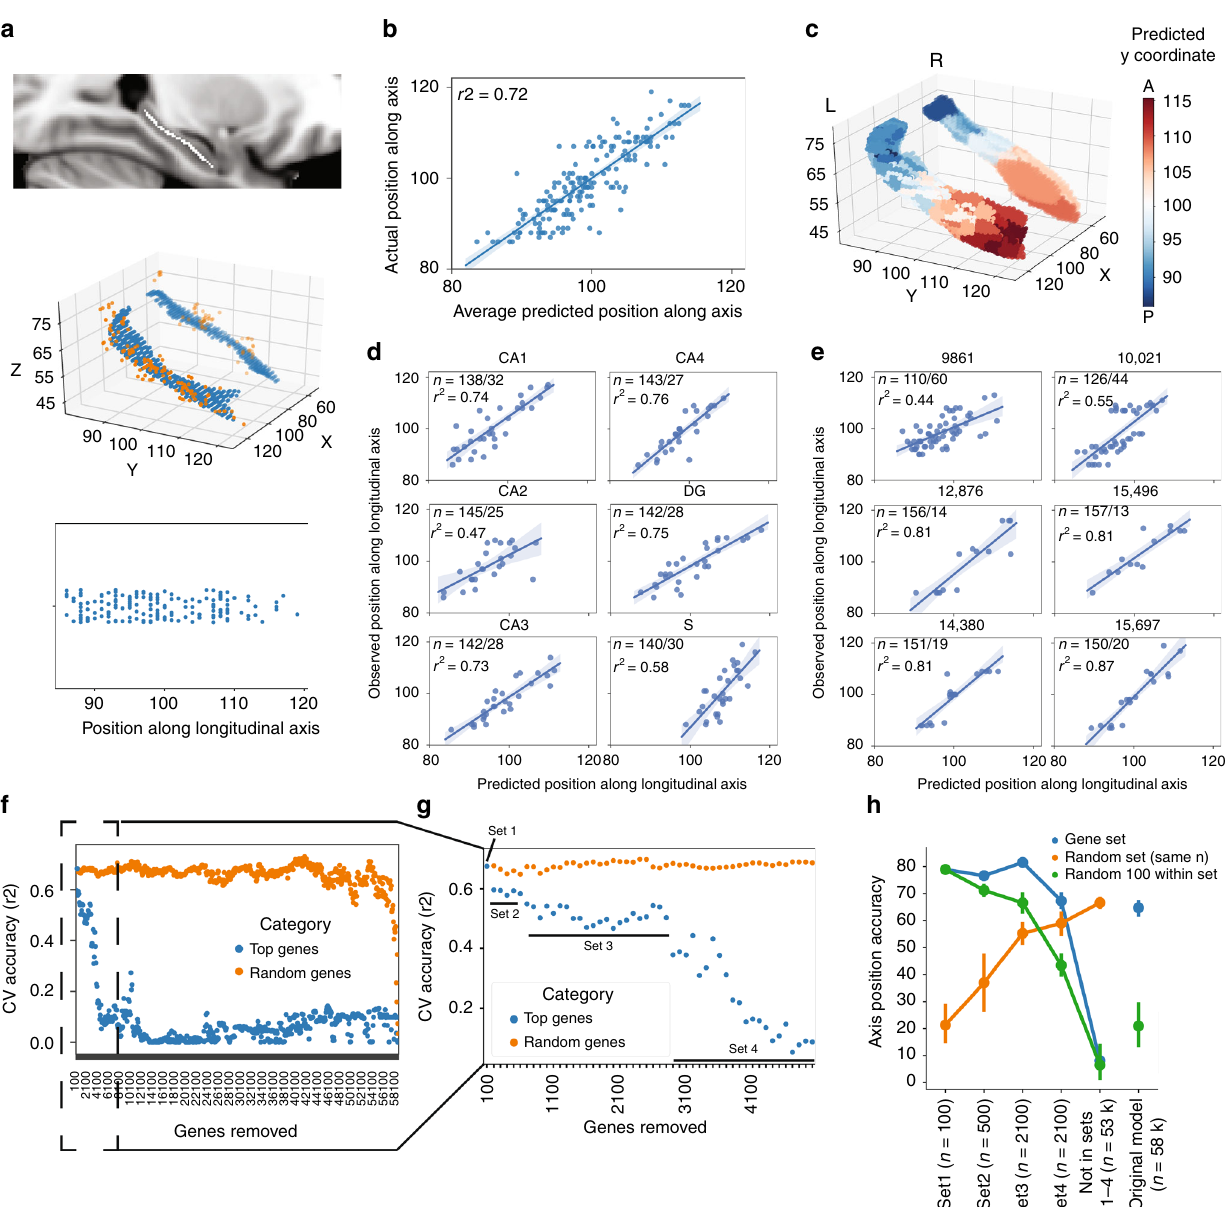
Fig. 1 Gene expression predicts the location of tissue samples along the long axis of the hippocampus. a (top) A curved skeleton of voxels was fi tted along the center of mass of the hippocampal volume. (middle) Tissue samples (orange) were matched to the closest skeleton voxels (blue). (bottom) A sample's position along the longitudinal axis was represented as the y-axis coordinate of the sample's matched skeleton-voxel. b Average predicted sample position (using gene expression) across ten separate 10-fold cross-validated LASSO-PCR models, compared to the actual position. c Render of the hippocampal surface where each vertex shows the predicted location of the closest (surface projected) sample to that vertex. The smooth appearance of the right hippocampus is related to the fact that less samples were available for this structure. d Predicted vs. observed sample locations for leave-one- sub fi eld-out models. For example, subpanel CA1 shows the predicted vs. observed position of samples extracted from CA1 (test set) when the model was trained without CA1 samples (training set). In each plot, N represents the number of samples in the training and test sets. e Predicted vs. observed sample locations for leave-one-donor-out models. f The 100 most important probes in the LASSO-PCR model were iteratively removed and, after each removal, 10-fold cross-validation accuracy predicting sample position along the longitudinal axis was recorded (blue dots). As a control, the same process was repeated but removing 100 random probes (orange). g The fi rst 50 rounds of 100-probe removal from Panel F. In fl ection points were identi fi ed after removing 100, 600, and 2700 genes. h Accuracy in predicting sample position was recorded for models using different gene sets identi fi ed by the in fl ection points in panel G (blue), samples of 100 random within-set probes (green), and samples of random probes (orange) as input. Each model was run ten times with different bootstrap samples to calculate con fi dence intervals (represented by error